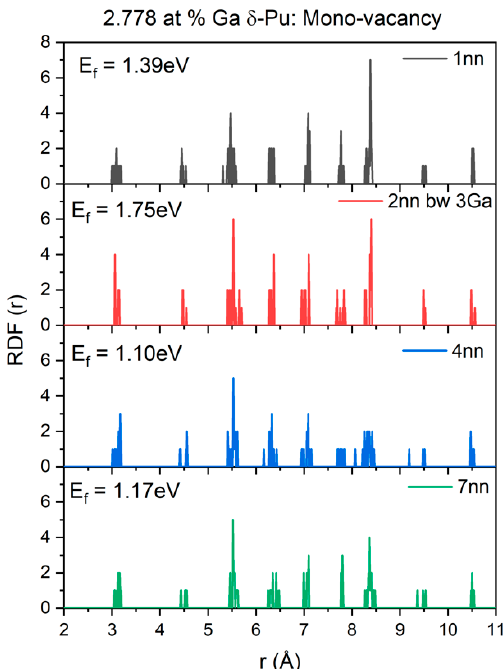
Figure 7. Radial distribution function (RDF) of a mono-vacancy from first (1nn), second in between three Ga atoms (2nn bw 3Ga), fourth (4nn), and seventh (7nn) nearest neighboring distance from the Ga atom for 2.778 at. % Ga. RDF is calculated from the perspective of the Ga atom. Table 2. Formation energies ( E vac ) of mono-vacancy at varying distances from the Ga. f at. %